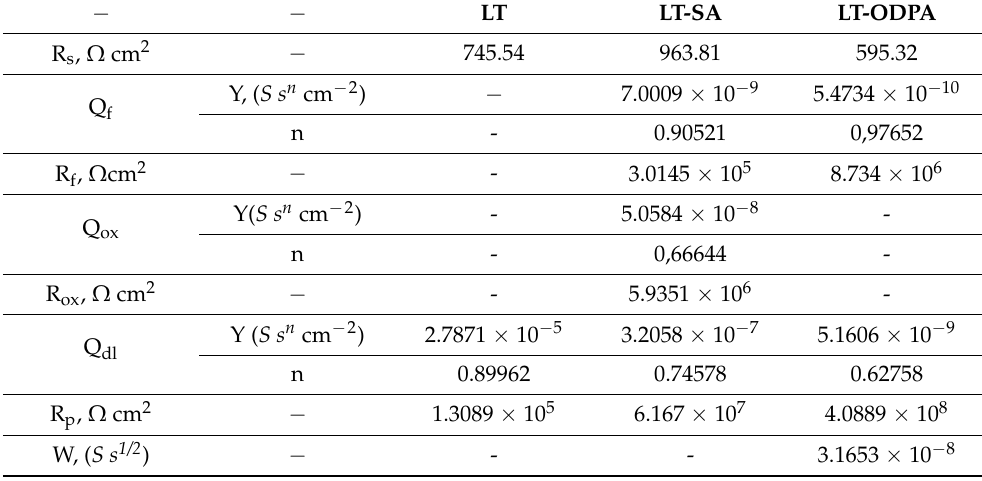
Table 3. Estimated parameters of equivalent electrical circuits used to describe the results of the